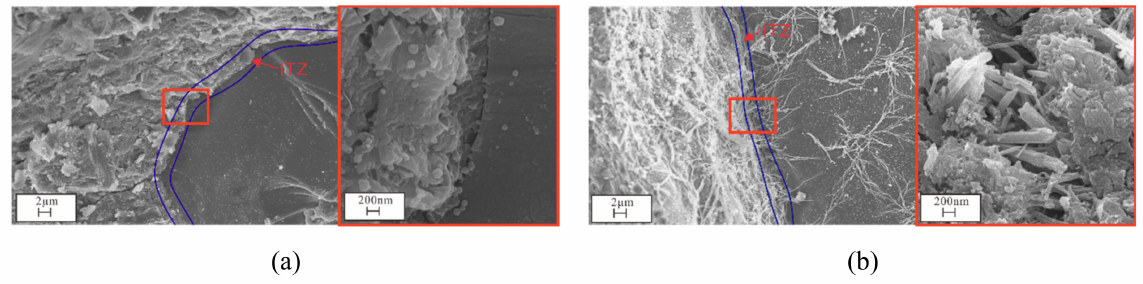
Figure 13. ITZ evolution in CS0 and CS3 solution after 360 days of erosion: ( a ) CS0, ( b )